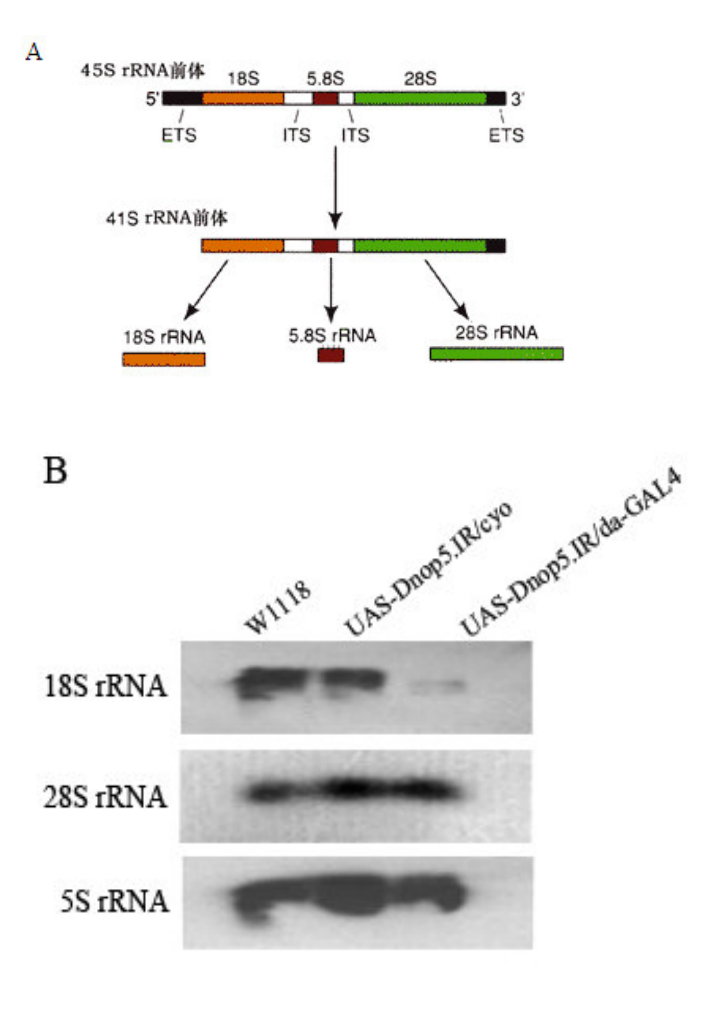
Figure 4. Depletion of DNop5 impairs synthesis of 18S rRNA. (A) The pre-rRNA processing pathway in eukaryotes.(B) Northern blot analysis of rRNA processing during DNop5